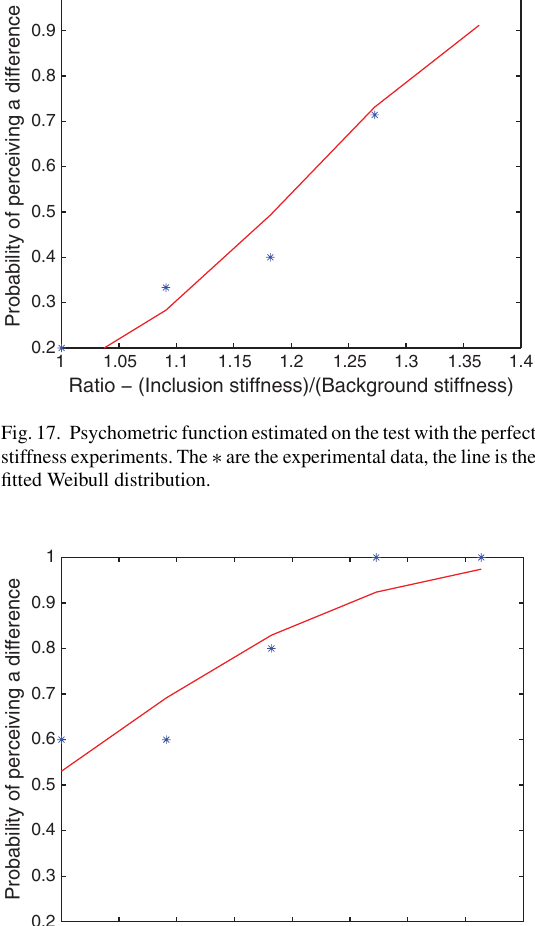
Table 2 Data perfect stiffness. The amount of correct